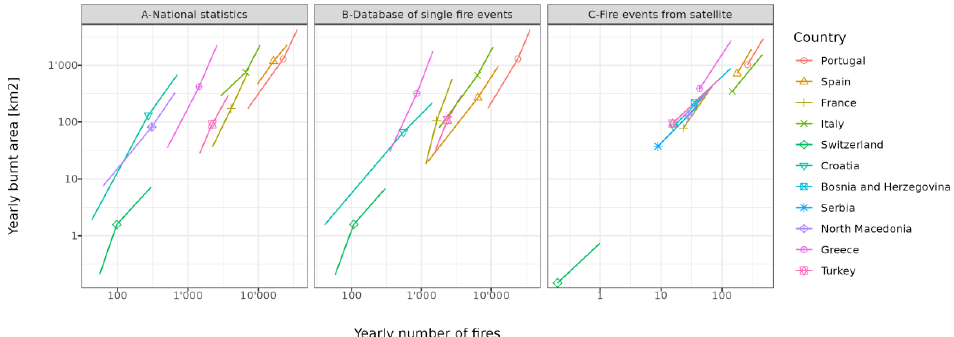
2 Figure 2. Yearly fire statistics available from 2000 to 2015 for the three different EFFIS forest fire datasets. Symbols represent means; segments stretch from lower to higher annual values. Lowest yearly values were not plotted for dataset C in order to enhance the figure readability. The X and Y axes are plotted on a logarithmic